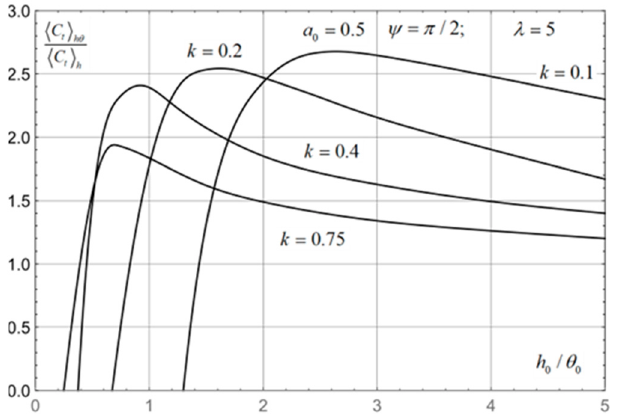
Figure 16. Ratio of period-averaged thrust coefficient for combined heave–pitch oscillations to that of purely heave oscillations versus amplitude ratio for different phase shift, a 0 = 0.5 and aspect ratio λ = 5.